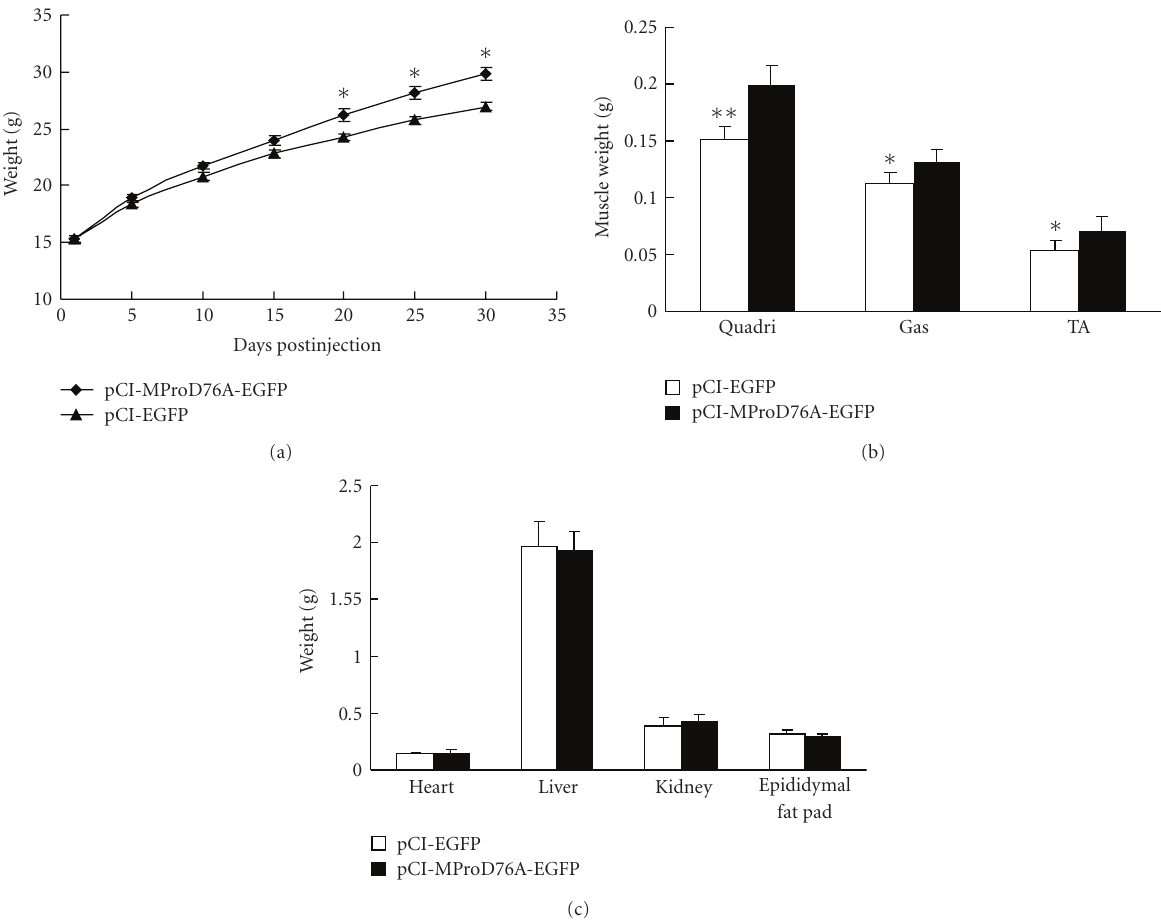
Figure 4: E ff ects of myostatin propeptide delivery on growth performance of mice. ( n = 6) . Four-week-old mice were injected with pCI- MProD76A-EGFP or pCI-EGFP into the regenerating quadriceps muscle. (a) Mice injected with pCI-MProD76A-EGFP showed a significant increase in body mass compared with pCI-EGFP control mice ( ∗ P < . 05) . (b) The mass of individual hindlimb muscles is increased in mice injected with pCI-MProD76A-EGFP ( ∗∗ P < . 01; ∗ P < . 05) . (c) Comparison of the heart, the liver, the kidney, and the epididymal fat pad weights, no significant di ff erence was found between the two